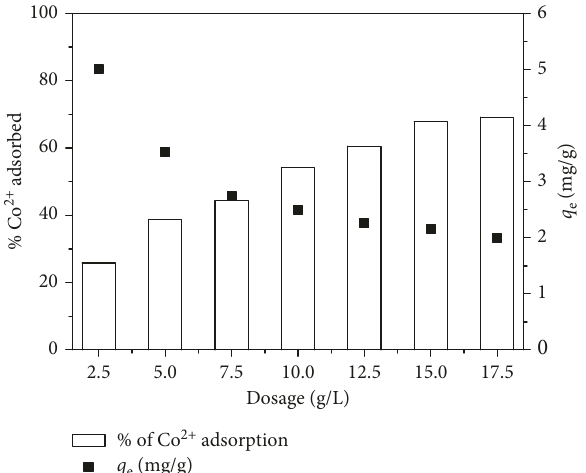
Figure 4: Effect of the adsorbent dosage on cobalt adsorption using MCSG60A. Conditions: [Co 2+ ] 50mg/L, time (cid:30) particle size powder, pH 6, and 1100rpm. (cid:30) (cid:30)